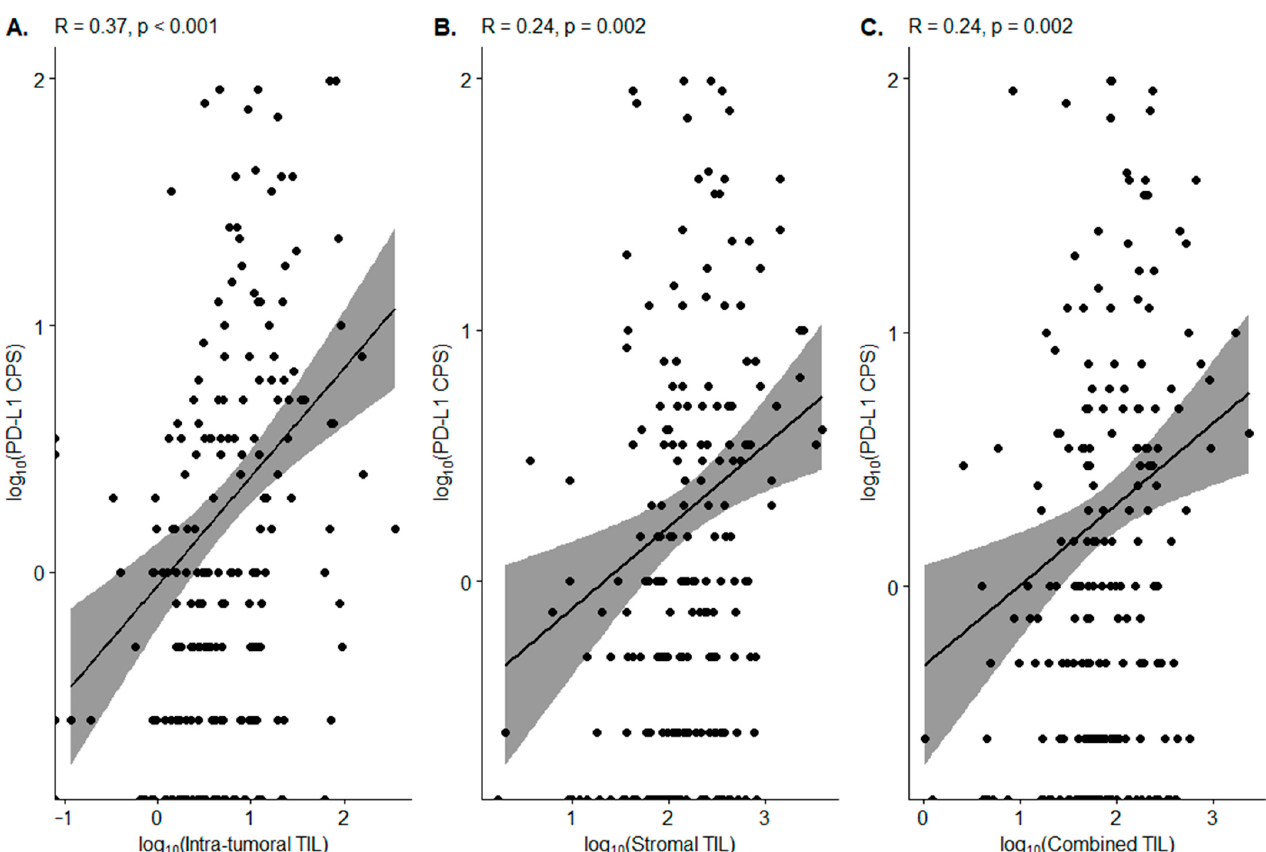
Figure 4. Correlation between the TIL density and the PD-L1 CPS. ( A ) Intra-tumoral TIL density; ( B ) stromal TIL density; ( C ) combined TIL density.